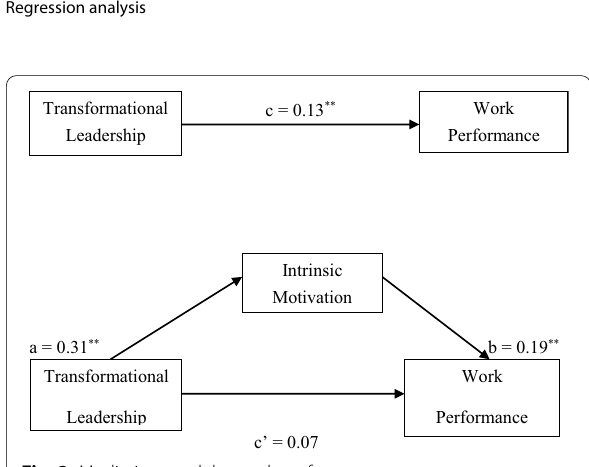
Regression analysis